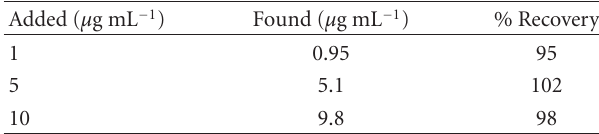
Table 3: Recovery of MEA in